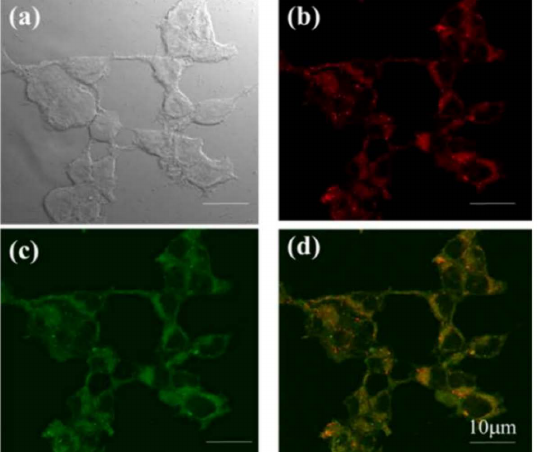
Figure 4. Confocal microscopic images of MCF-7 cells after 4 h of incubation with 17 : ( a ) bright field, ( b ) fluorescence of Mito Tracker Deep Red, ( c ) fluorescence of 17 , and ( d ) merged image of ( b , c ). Scale bar = 10 µ m. Adapted from